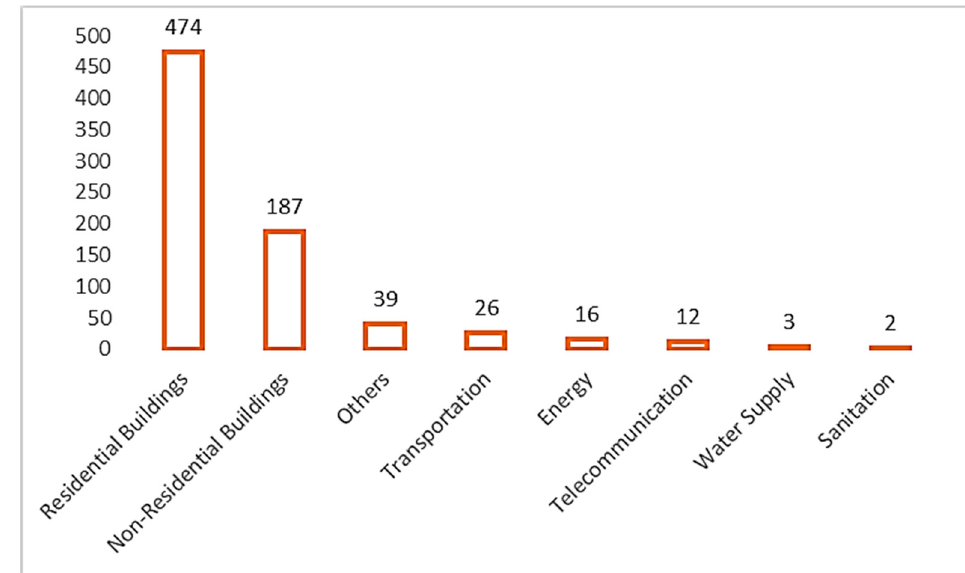
Figure 4. Areas of respondents’ construction procurement experience.